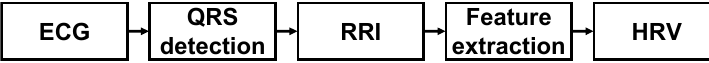
Figure 1. Overview of data preprocessing and feature extraction.